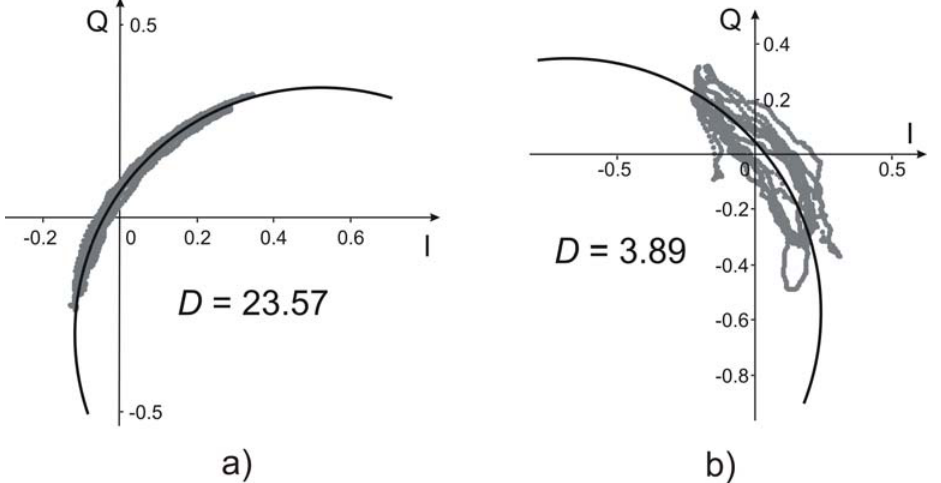
Figure 5. Experimental results in I-Q plane. Examples of two extreme cases: (a) valid data with D = 23.57; (b) discarded data with D = 3.89.